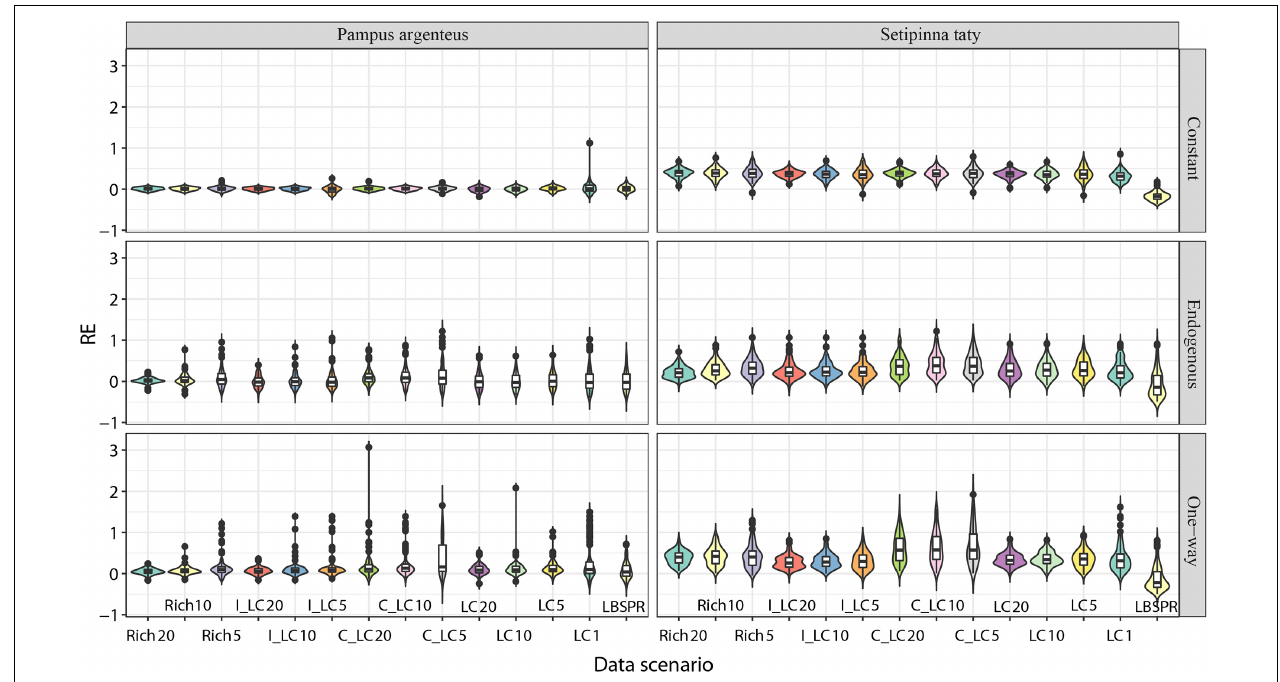
FIGURE 5 | Distribution of relative error ([estimated – true]/true) for SPR in the last year of the data series for 100 iterations of simulated populations ( S. taty and P. argenteus in the Bohai and Yellow Seas) across LIME and LB-SPR data availability scenarios for the two life-history types and scenarios of equilibrium and variable fishing mortality and recruitment with 250 length measurements